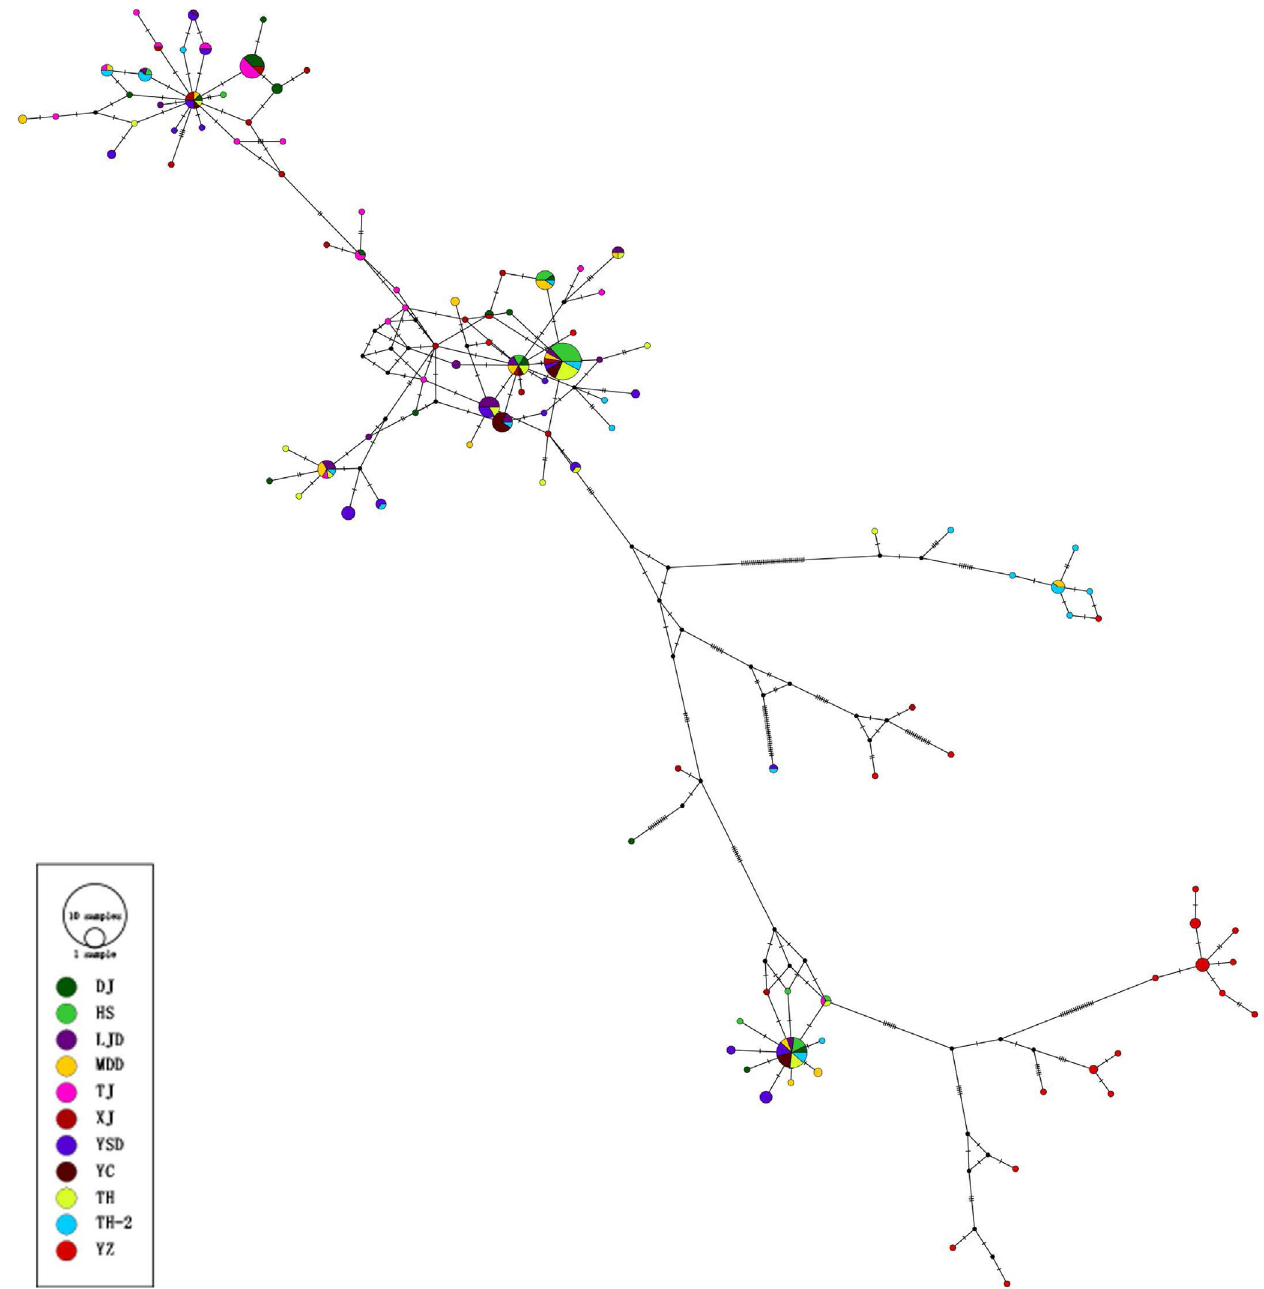
Fig. 2. The median-joining network based on haplotype frequencies of M. nipponense . The circle represents haplotype; circle size is proportional to the number of individuals in the haplotype. Each line in the network represents a single mutational change, and the branches are scaled to the number of polymorphic sites between each haplotype. Each black circle represents one missing